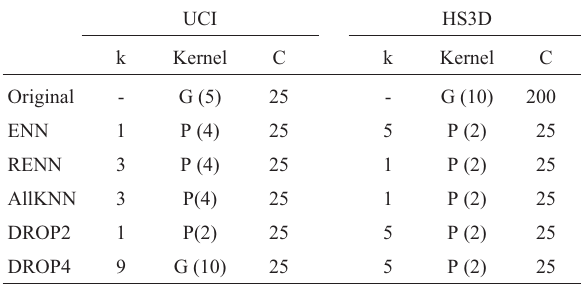
Table 4 - Best SVMs models and corresponding pre-processing technique parameters.